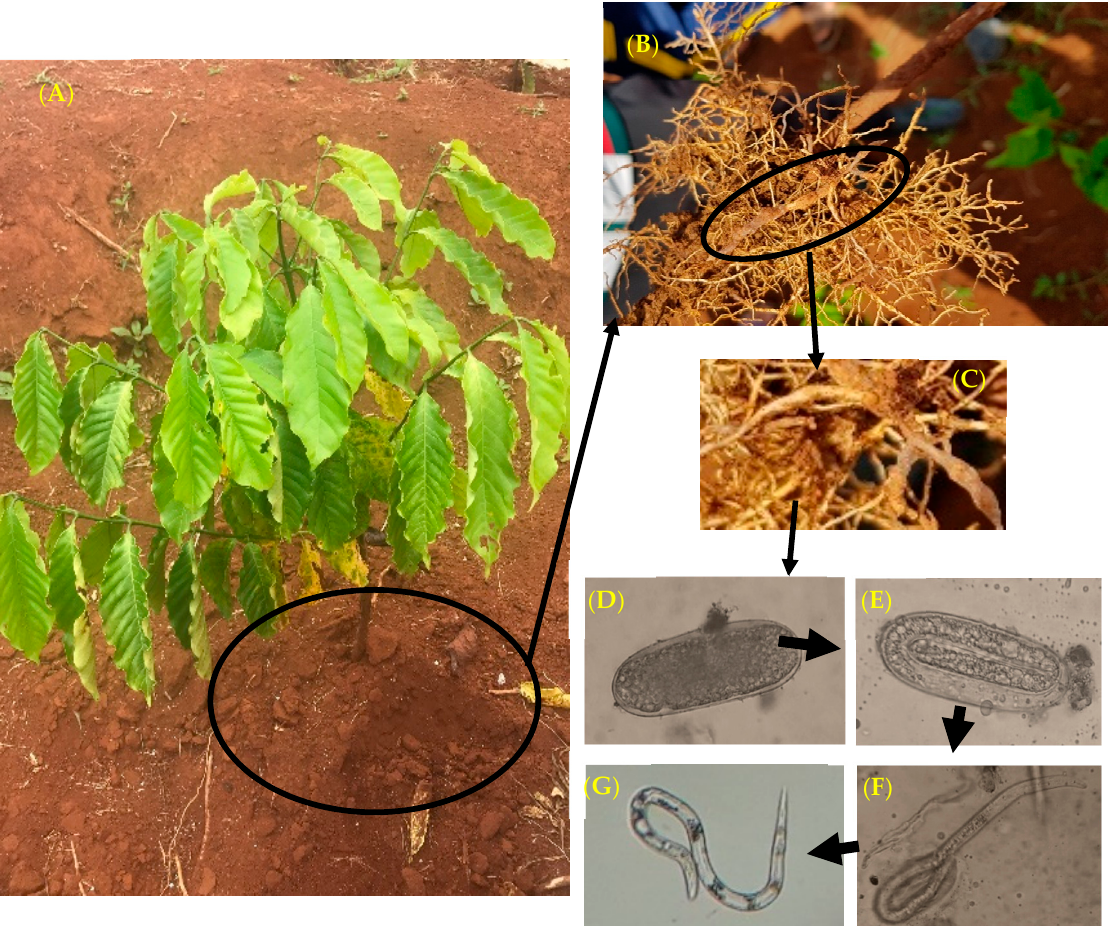
Figure 1. Preparation of eggs and root-knot nematodes ( J2 ). The sick Robusta coffee ( A ) showing symptoms of nematode infection with yellow leaves was used, and its root system was harvested ( B ). Sick roots having root-knots ( C ) were collected to isolate nematode eggs ( D ), then these eggs were incubated for 3–5 days for their development ( E ) and hatching ( F ) to obtain fresh J2 nematodes ( G ). The images of coffee nematode eggs and J2 nematodes were observed and recorded using an Optical Olympus Microscope (Model CH30RF200, Olympus Co., Tokyo, Japan).